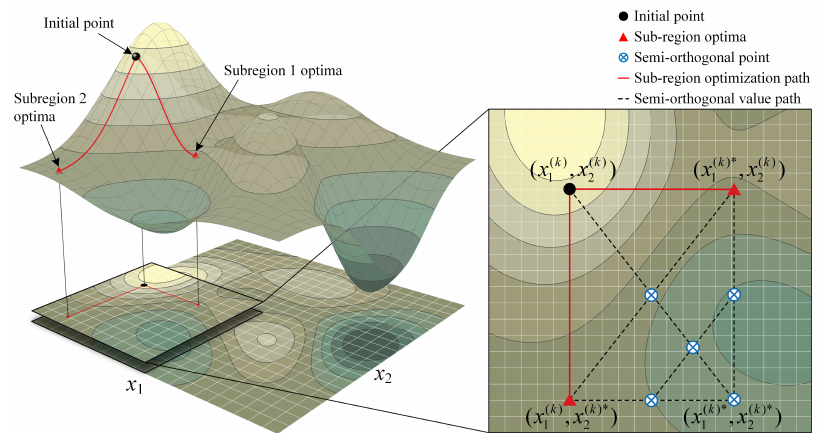
Figure 4. Schematic of semi-orthogonal values of sub-region